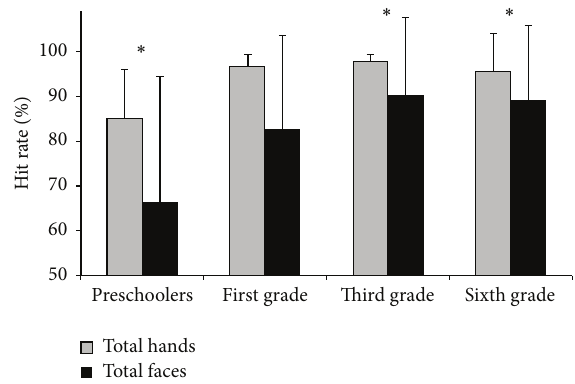
Figure 1: Mean hit rates for visual stimuli depicting faces showing expressions of pain or neutral expressions (faces) and hands in painful or nonpainful situations (hands) for each group. Error bars represent 1SD. Significant differences (alpha level of 0.05) are indicated by an